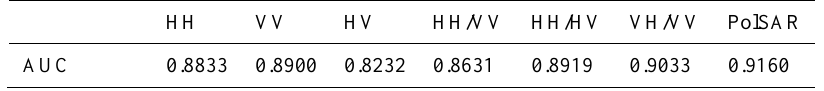
Table 3. The AUC of G 0 distribution texture parameters in SAR data with different